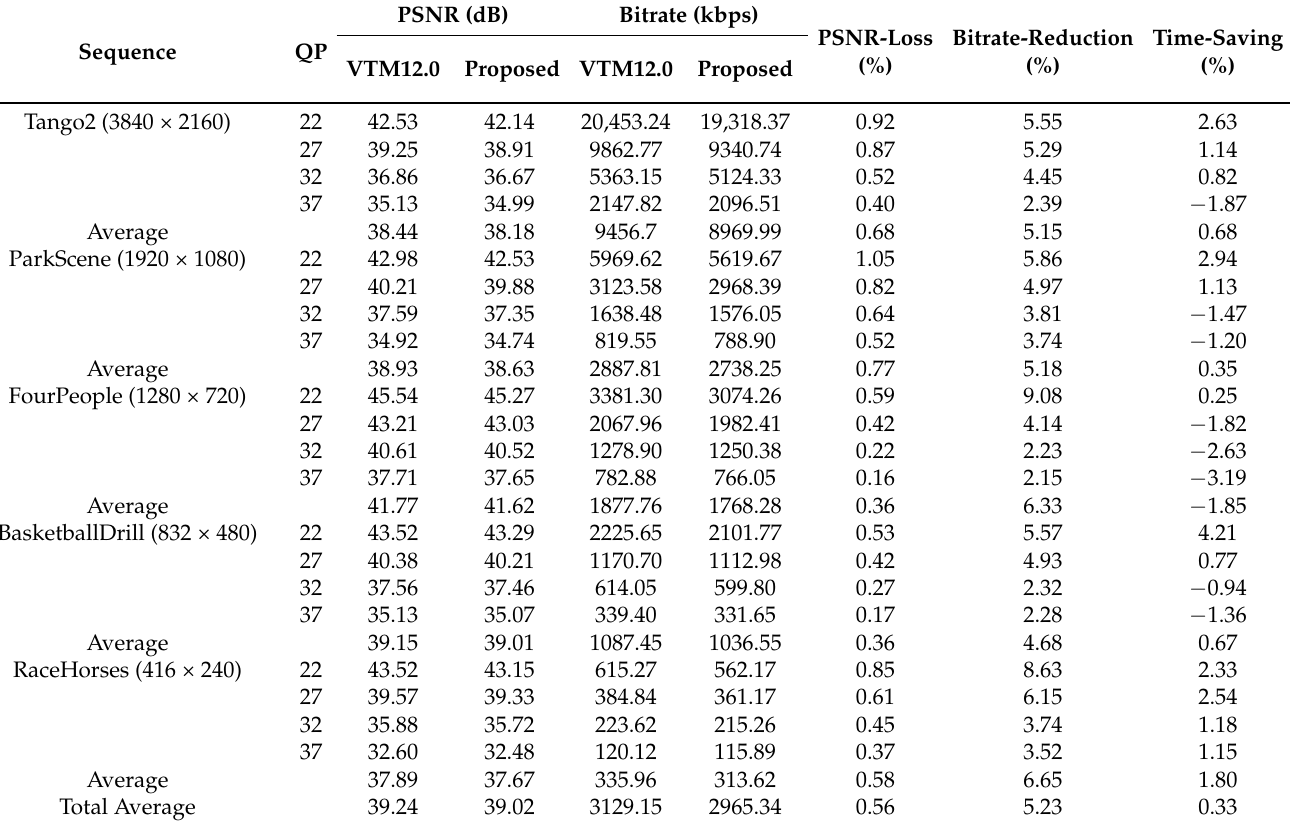
Table 3. Performance comparison of quantization control algorithm and VVC reference software.